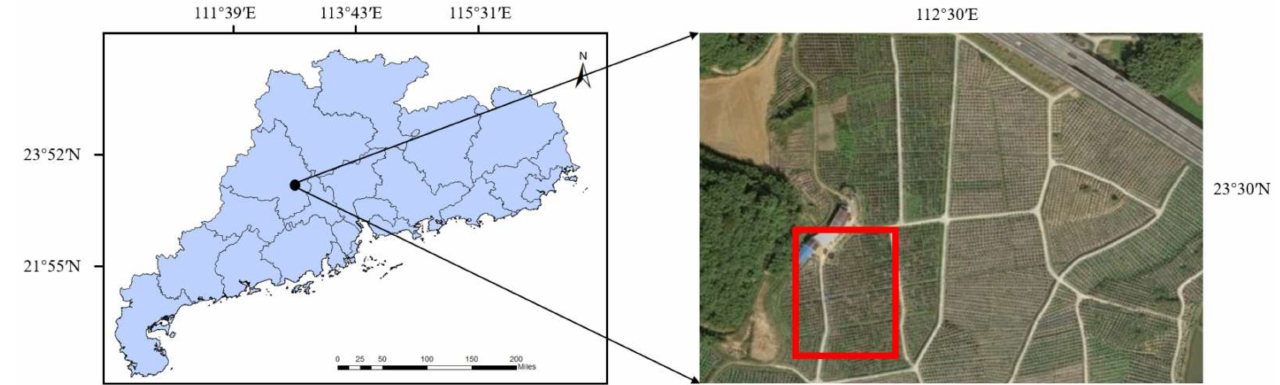
Figure 1. The study area ( right ) circled by the red box is located in Guangdong Province ( left ), China (23 ◦ 36 (cid:48) N, 112 ◦ 68 (cid:48) E).